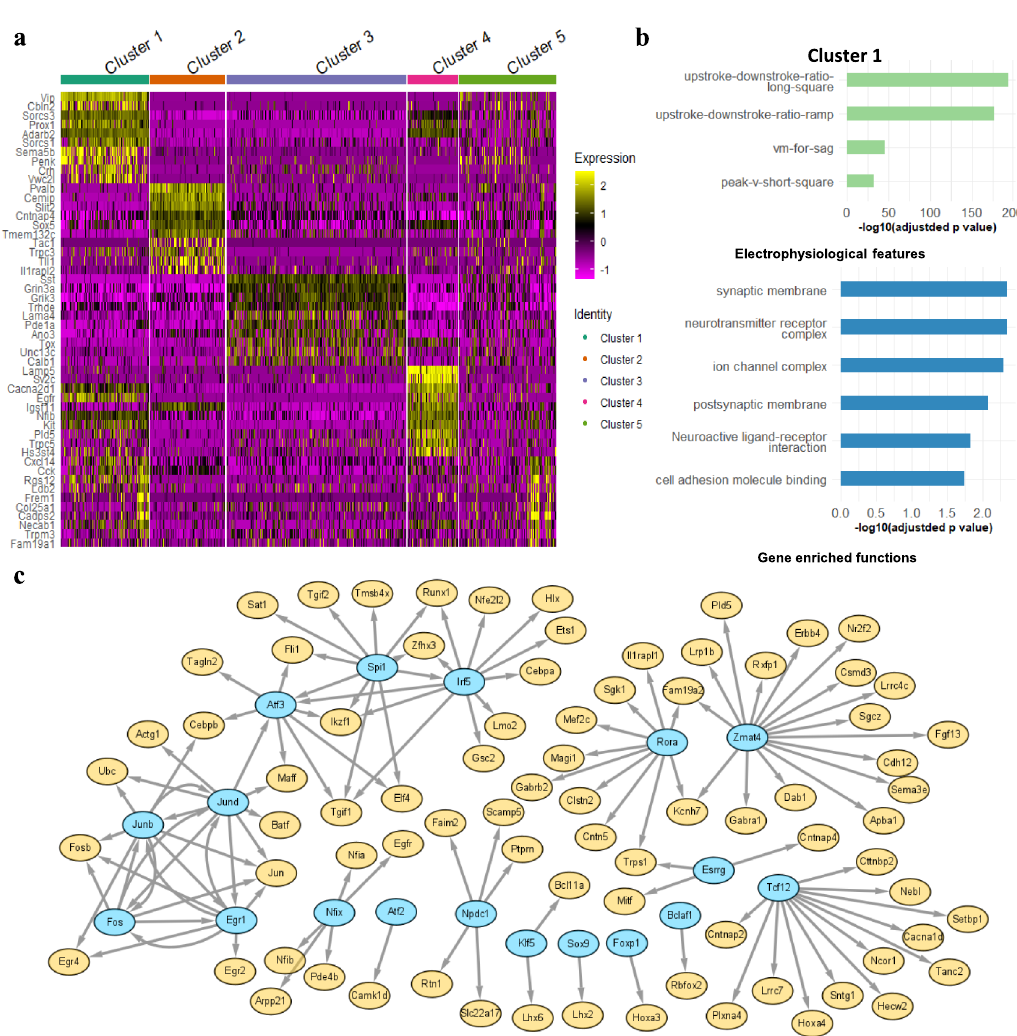
Fig. 4 Differentially expressed genes, enrichments, and gene regulatory networks for cross-modal cell clusters. a The gene expression levels across all 3654 cells for Top 10 differential expressed genes (DEGs) of each cross-modal cell cluster in the mouse visual cortex. The cell clusters were identi fi ed by the gaussian mixture model (Methods). The expression levels are normalized (Methods). b The select enriched biological functions and pathways of DEGs (GO and KEGG terms with adjusted p value <0.05) and representative electrophysiological features (adjusted p value <0.05) in Cluster 1 of the mouse visual cortex. c Gene regulatory networks that link transcription factors (TFs, cyan) to target genes (Orange) in Cluster 1 of the mouse visual